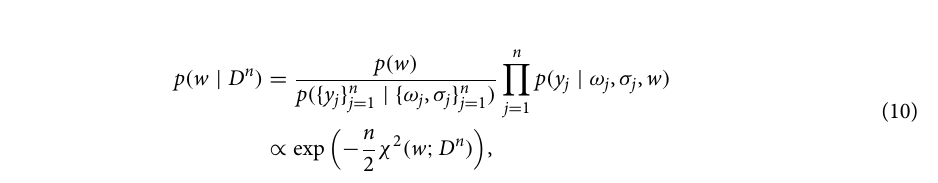
Figure 3. Posterior probability against form of ion velocity distribution function. The assumed forms are no ions (function I), a Maxwellian (function II), a Maxwellian with Zeeman splitting (function III), a slowing-down (function IV), and a slowing-down with Zeeman splitting (function